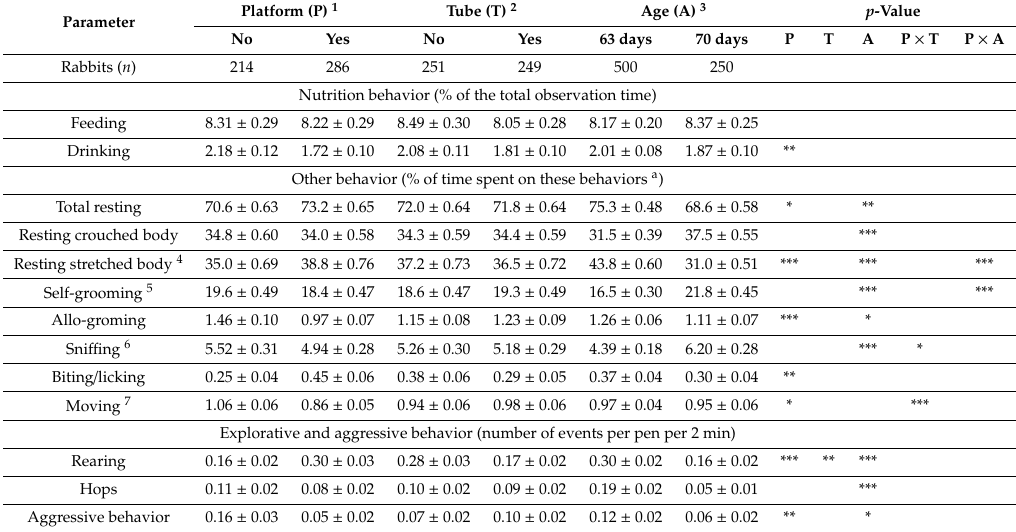
Table 4. E ff ects of enrichment (platform or tube) and age (63 days and 70 days) on rabbit behavior (least square means ± standard error) registered across 24